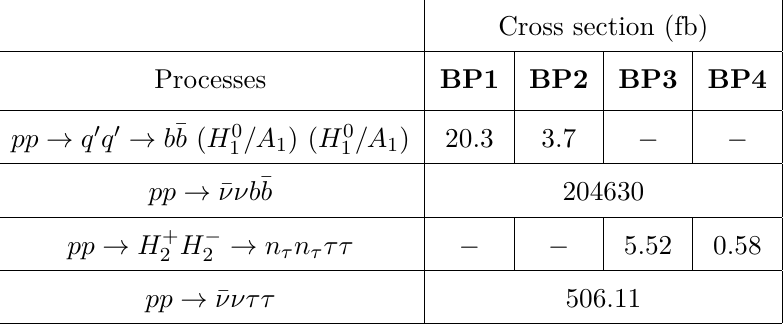
Table 10 . Cross section times BR for the selected channel and the corresponding SM background at the 14 TeV LHC for the four chosen BP